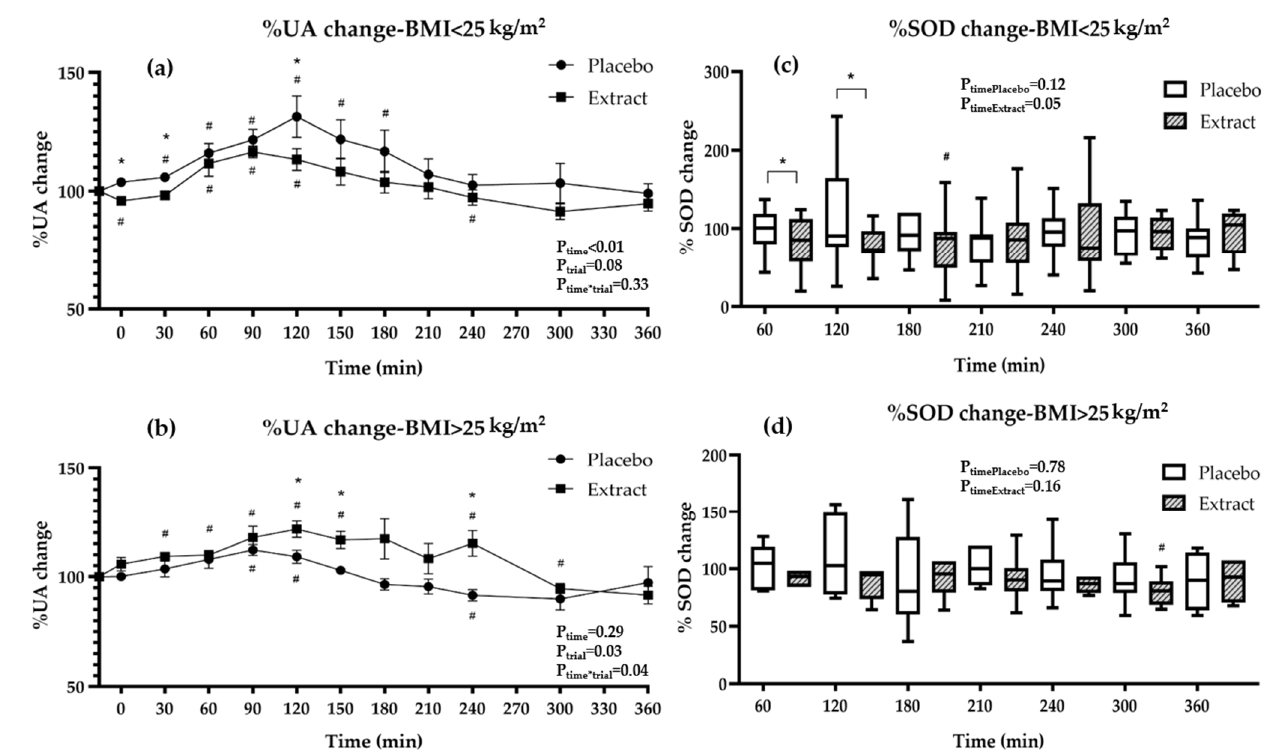
Figure 1. Percentage of change in endogenous antioxidant biomarkers between interventions for ( a , c ) participants with BMI < 25 kg/m 2 , ( b , d ) participants with BMI > 25 kg/m 2 . Data are presented as means ± SEM or median (25th–75th quartile). BMI, body mass index; SOD, superoxide dismutase; UA, uric acid. P time , P trial , P time*trial from RMANOVA, P timePlacebo/Extract from Friedman’s 2-way ANOVA. # p ≤ 0.05 compared to baseline values from paired samples t -test or Wilcoxon paired test, respectively. * p ≤ 0.05 between interventions from paired samples t -test or Wilcoxon paired test,